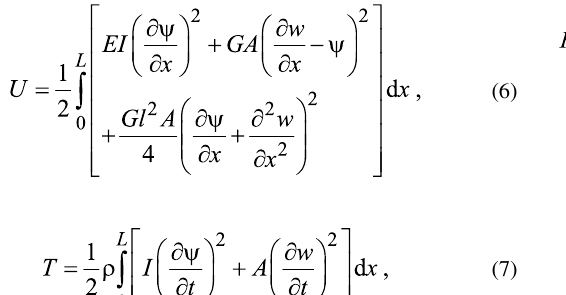
By replacing the equations of non-zero elements, one can obtain the strain, stress, curvature and couple stress matrices along with the non-zero elements of the rotation vector. Additionally, the strain and kinetic energy and the work of external force applied on the beam element are, respectively, defined as